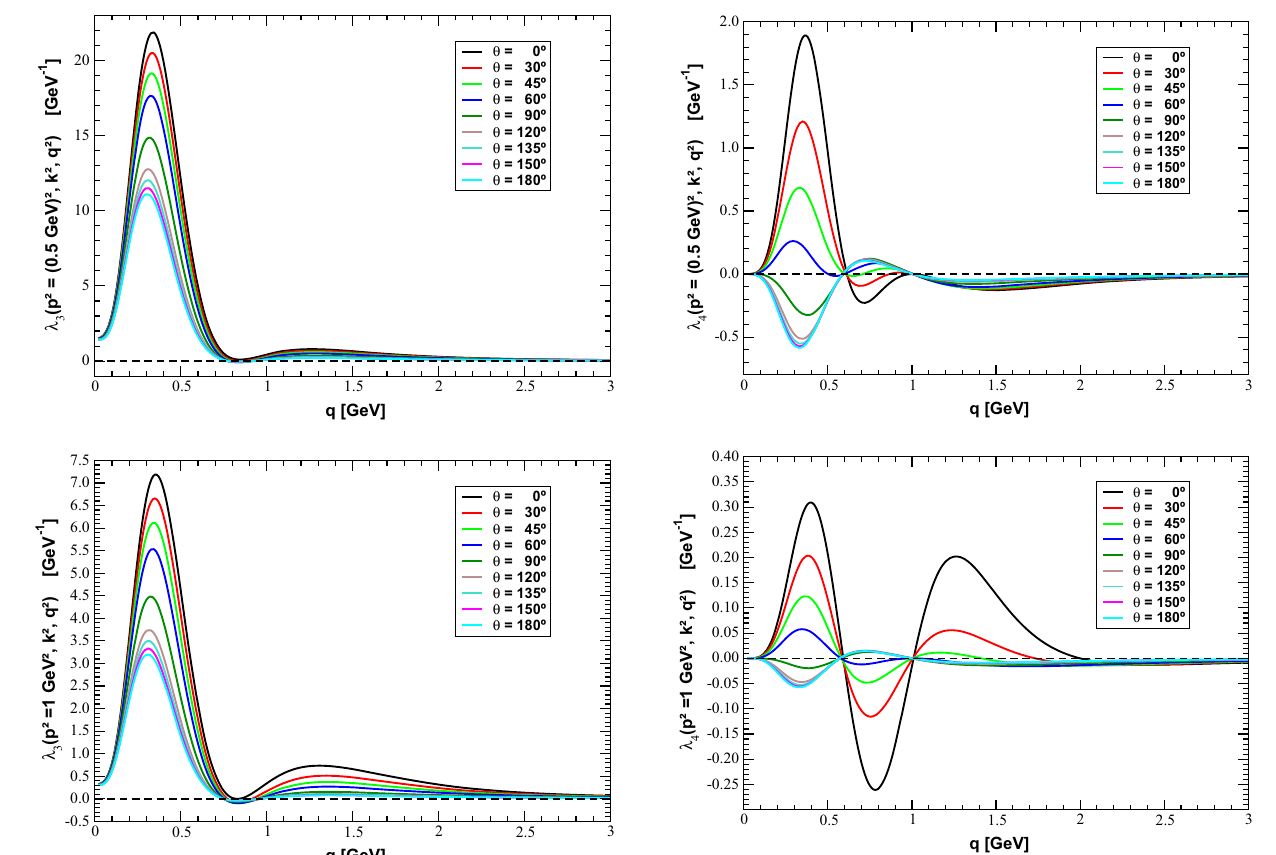
Fig. 40 λ 3 for p = 0 . 5 GeV (top) and p = 1 GeV (bottom) and various θ